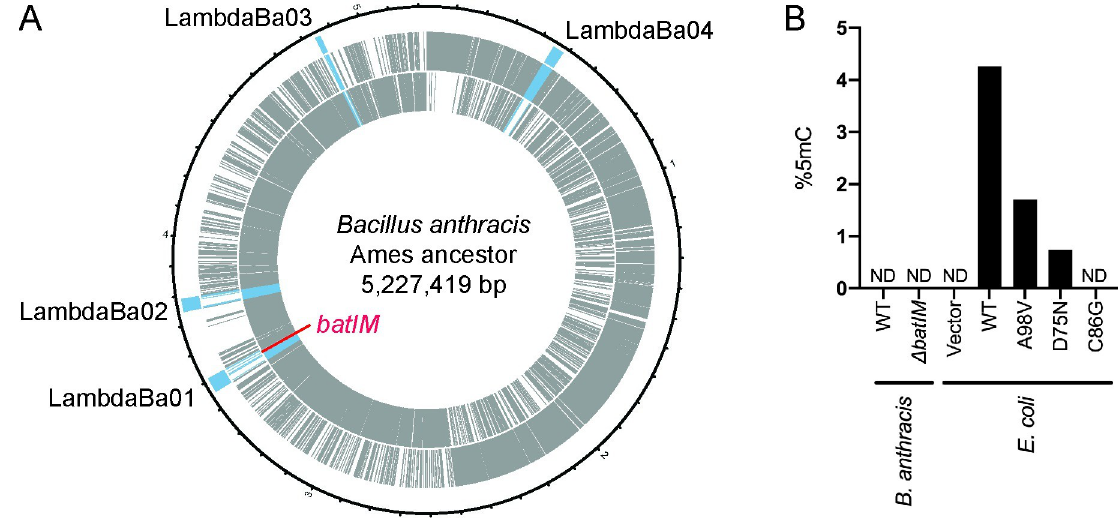
Fig 1. Position of batIM and its activity in vivo . (A) A map of the chromosome of B . anthracis Ames ancestor. The outermost blue bars represent the region of prophages. Gray bars represent the position of coding sequences: outer, coding sequences on the leading strand; inner, coding sequences on the lagging strand. Prophage genes were colored blue and the batIM gene was colored red. (B) Measurement of 5mC using UPLC-MS/MS for genomic DNA isolated from B . anthracis strains and M.BatI induced E . coli strains. ND, not detected.